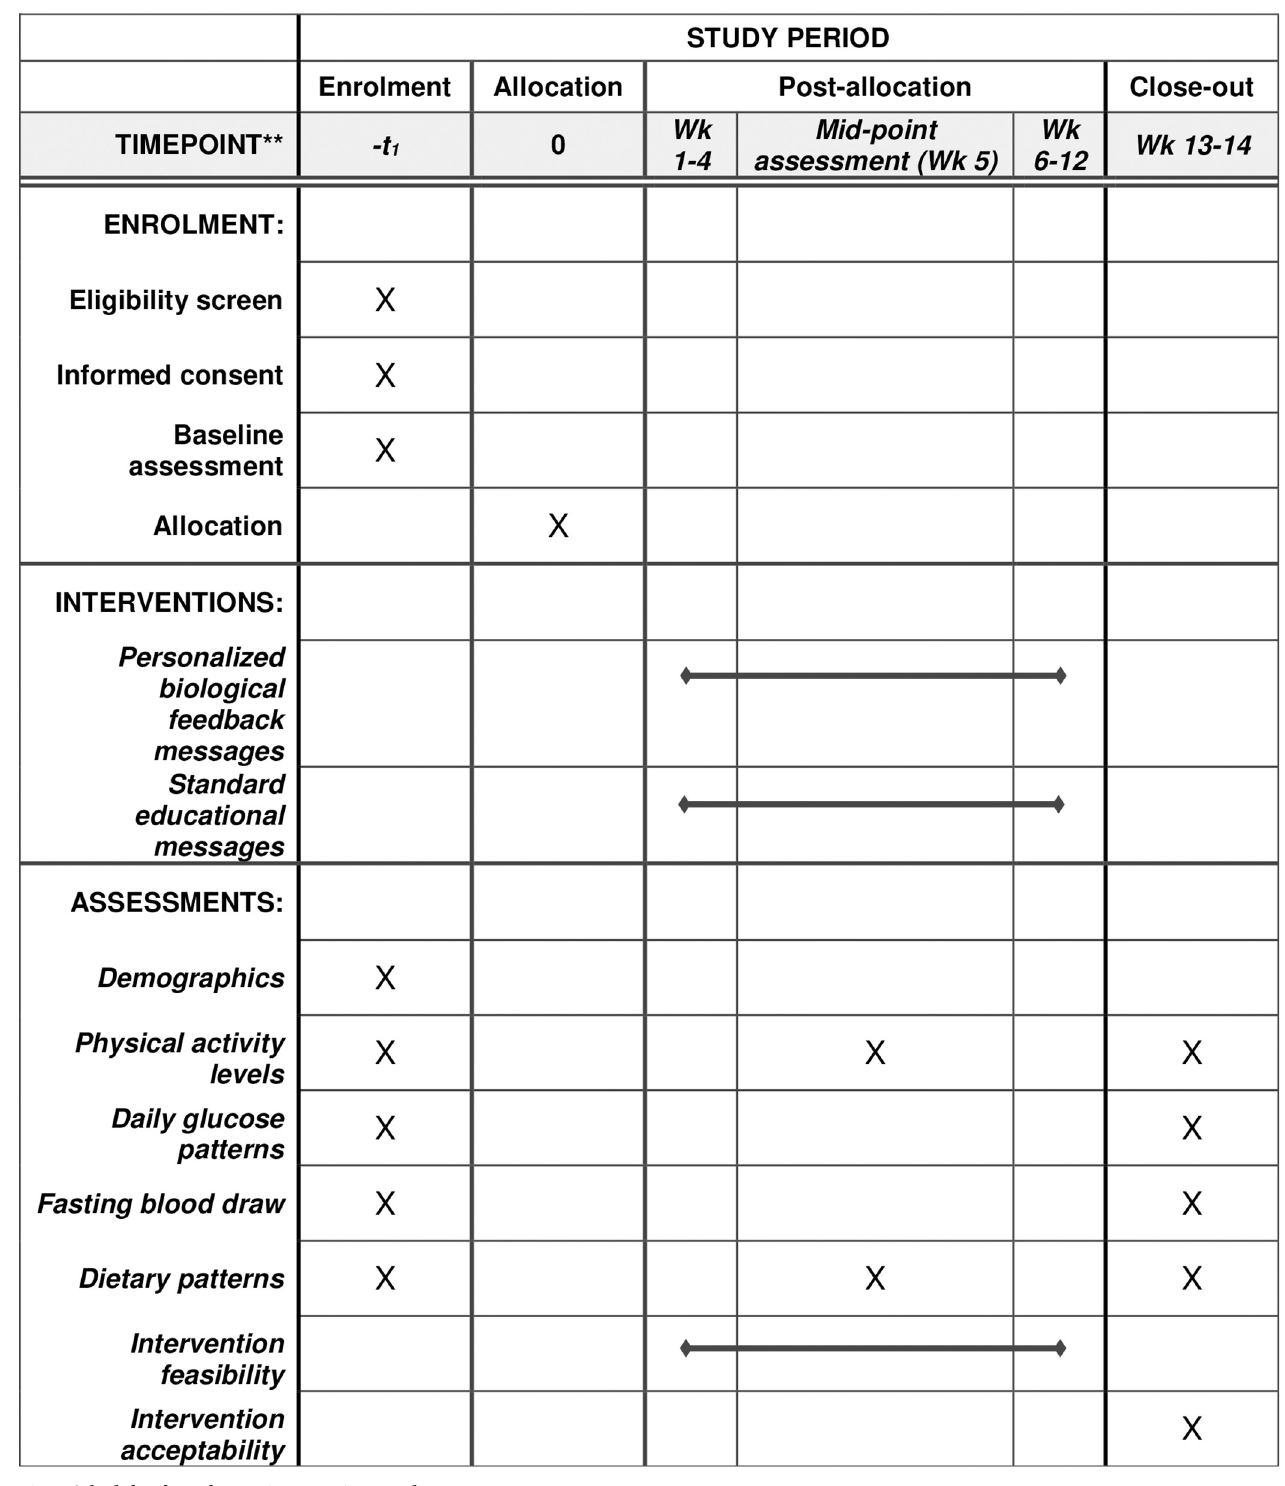
Fig 1. Schedule of enrolment, interventions, and assessments.